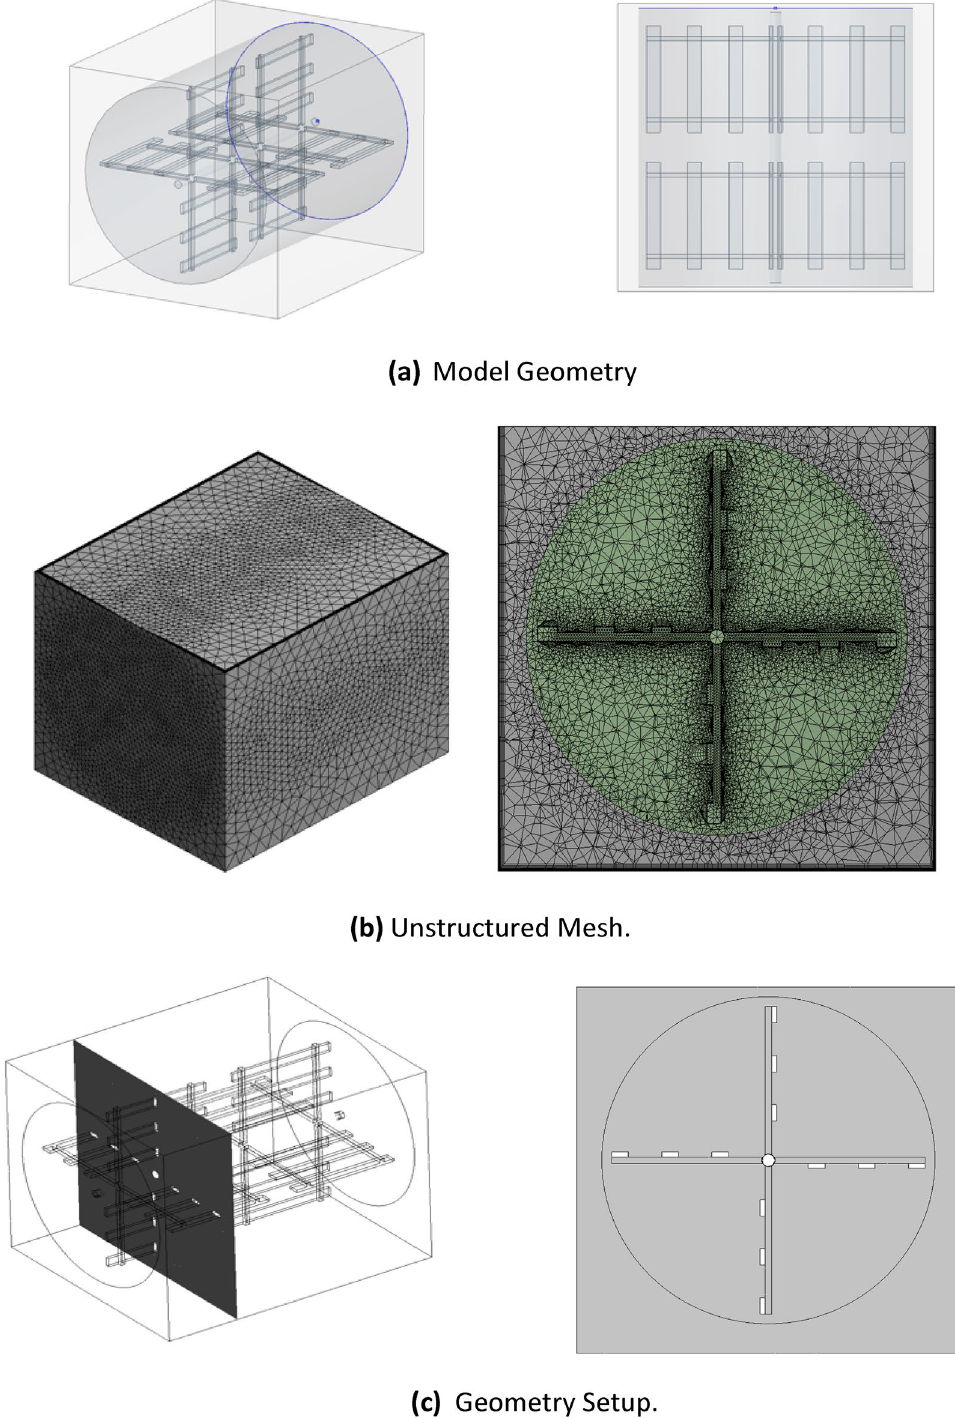
Figure 3. ANSYS-fluent 3-D and schematic views of model geometry, ANSYS-fluent mesh of flocculator body at plane of interest, ANSYS-fluent schematic views at plane of